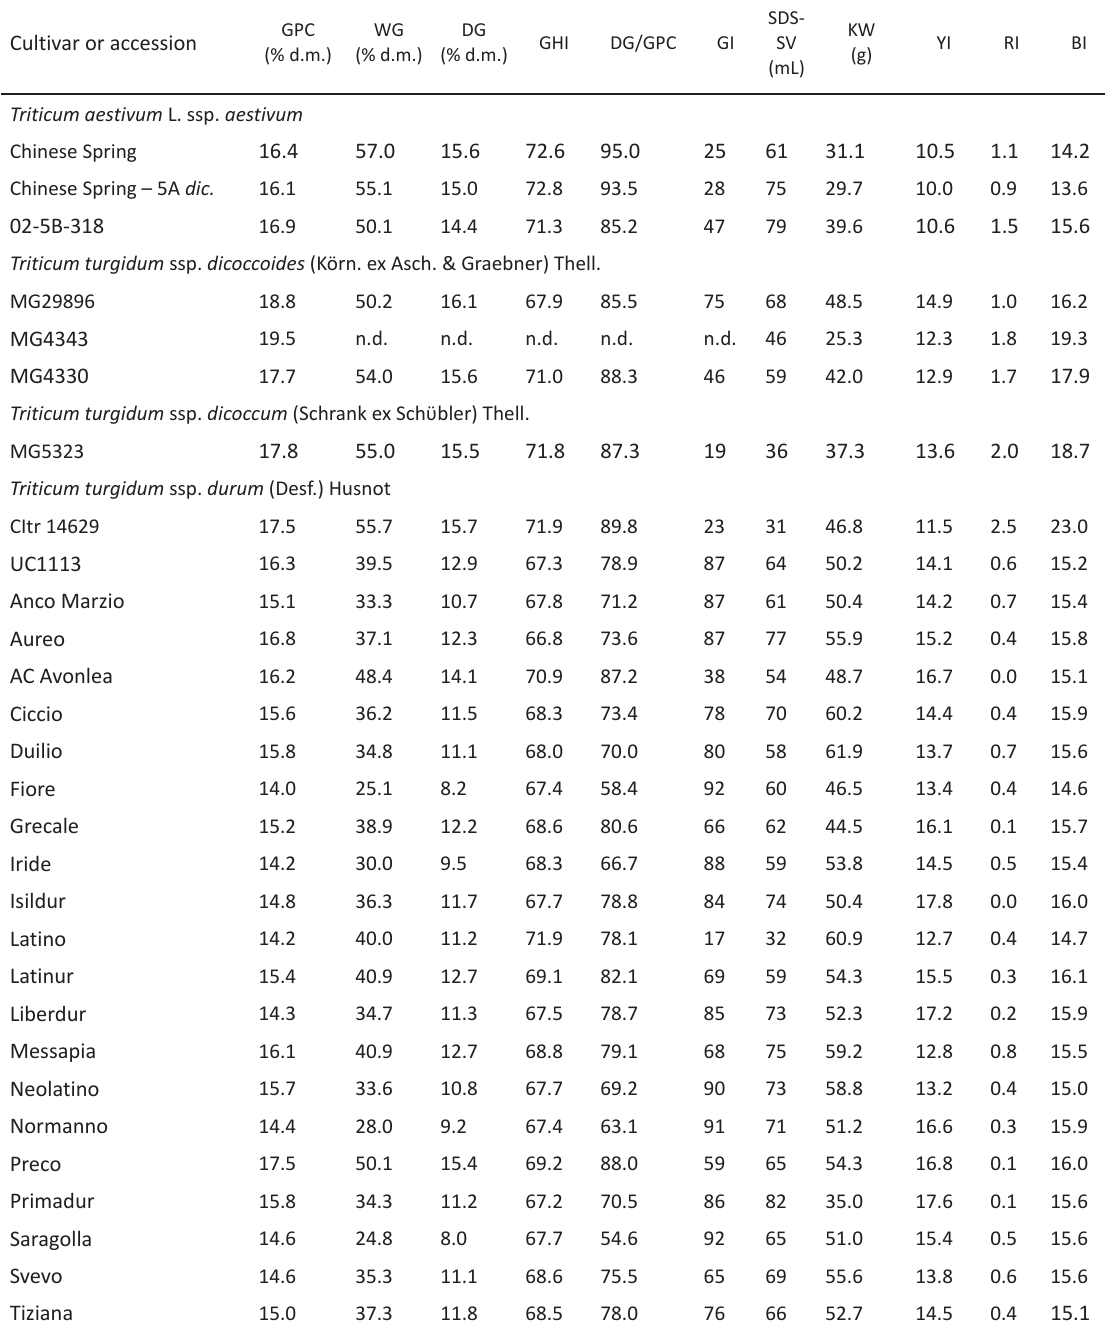
Table 5. Grain protein content (GPC), wet gluten (WG), dry gluten (DG), gluten hydration index (GHI), dry gluten/protein ratio (DG/GPC), gluten index (GI), sodium dodecyl sulphate sedimentation volume (SDS-SV), thousand-kernel weight (KW), and color indices (YI = yellow index; RI = red index; BI = brown index) of whole meal of parental lines of wheat mapping populations grown in Valenzano (Bari, Italy) in 2013 (mean of three field replications) SDS- GPC WG DG Cultivar or accession GHI DG/GPC GI SV BI (% d.m.) (% d.m.) (% d.m.)